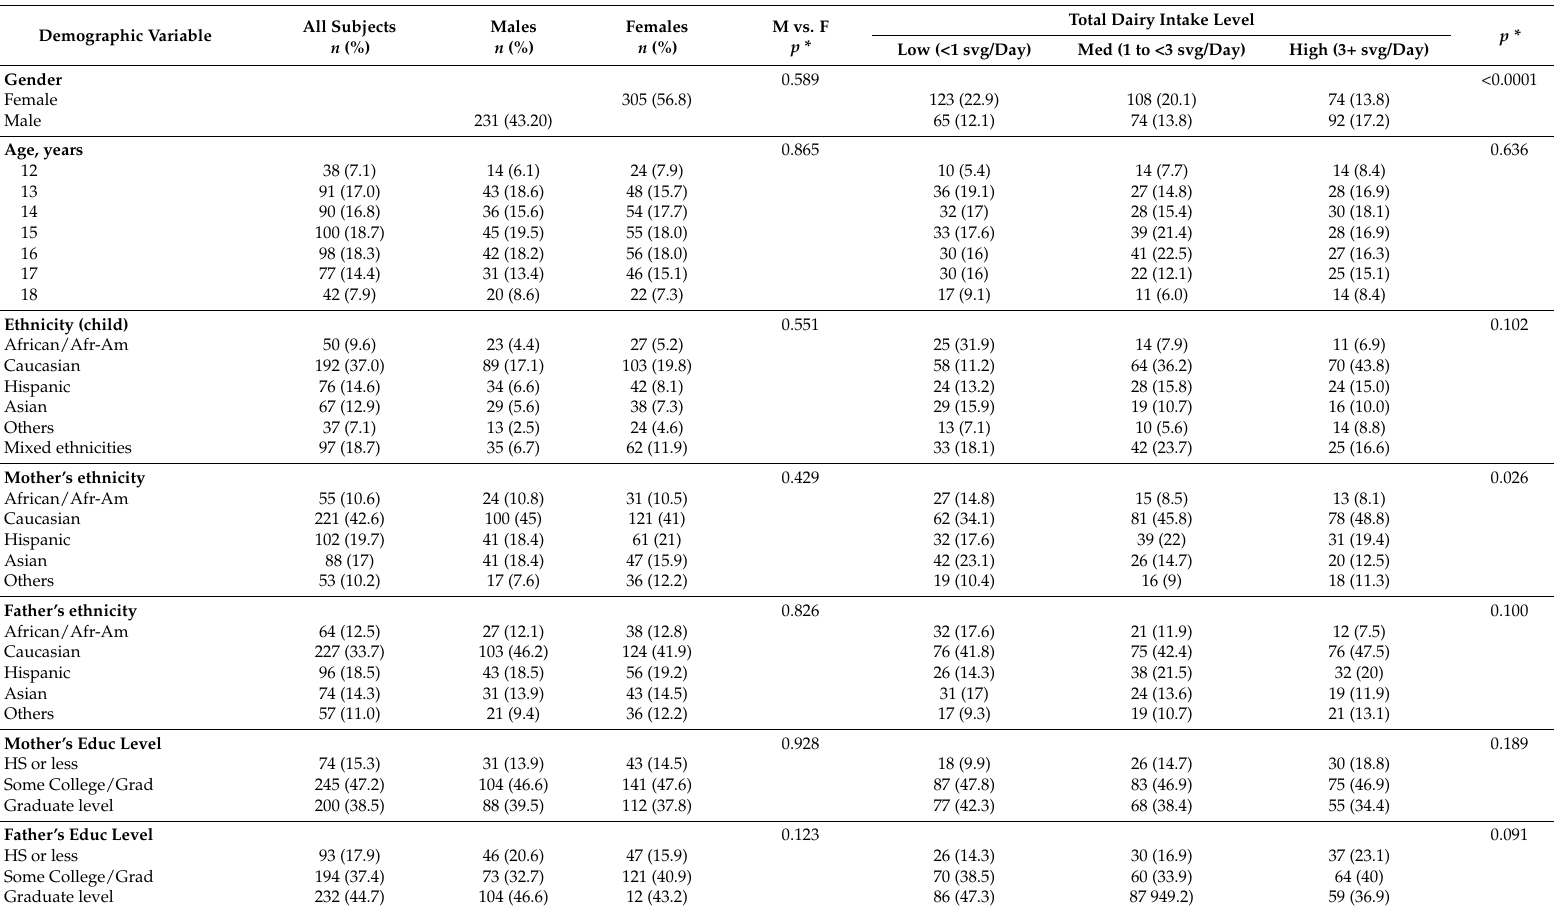
Table 1. Demographic profile of subjects and distribution according to level of dairy consumption ( n =